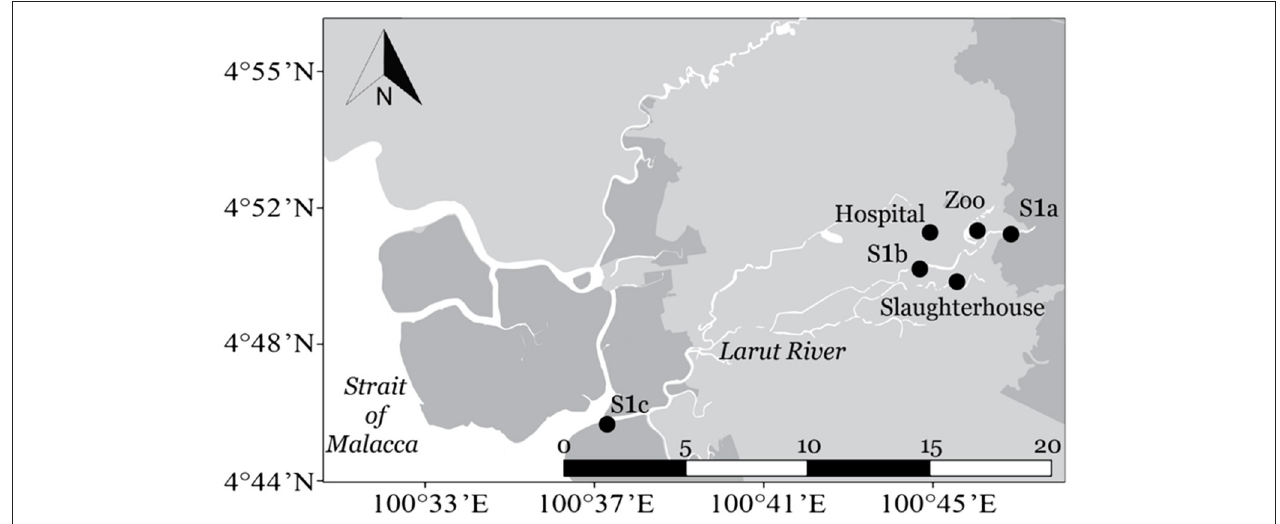
FIGURE 1 | Map of sampling sites along Larut River. Geolocation: S1a (4 ◦ 51.158’N, 100 ◦ 45.737’E), Zoo (4 ◦ 51.101’N, 100 ◦ 45.045’E), Hospital (4 ◦ 51.149’N, 100 ◦ 44.018’E), Slaughterhouse (4 ◦ 50.238’N, 100 ◦ 44.709’E), S1b (4 ◦ 50.535’N, 100 ◦ 43.925’E), and S1c (4 ◦ 50.140’N, 100 ◦ 37.583’E).